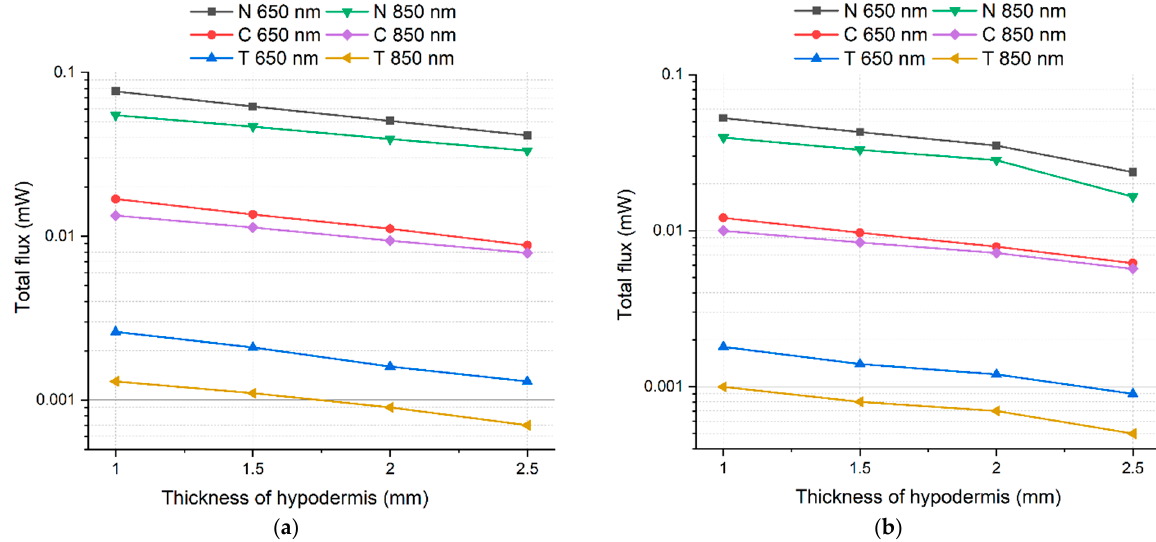
Figure 9. Dependence of the change in the total flux (power) of radiation coming to the camera detector on the change in the hypodermis thickness and on the presence of pathology in the sinuses of female ( a ) and males ( b ) for wavelengths of 650 and 850 nm. The following labels are used: “N” for healthy tissues, “C” for tissues with cyst, and “T” for tissues with tumor.